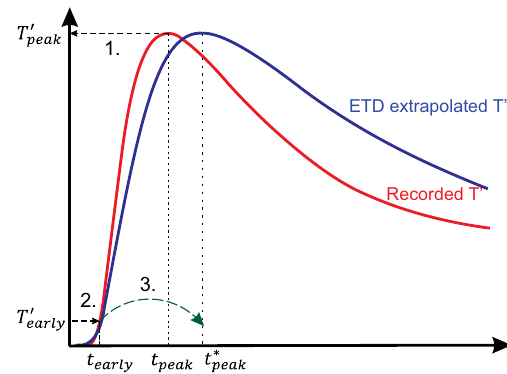
Figure 1. Three steps of applying early-time diagnostics (ETD) on a thermal breakthrough curve (BTC). (1) Identify the peak T (cid:48) value on the recorded BTC. (2) Find the early-time value to the corre- sponding fraction of the signal. (3) Extrapolate the early time to the ideal peak time using the transformation factor, f α